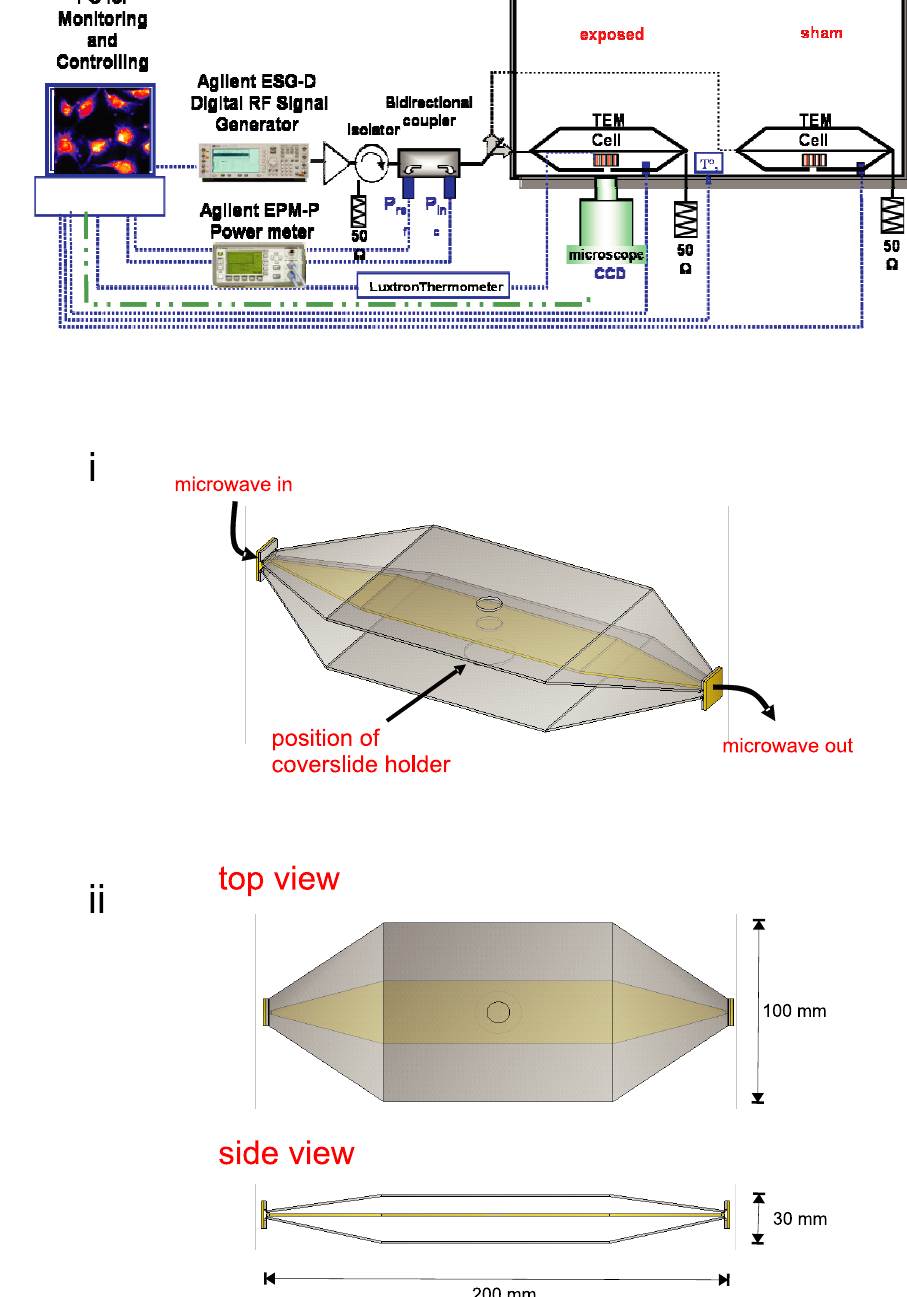
Figure 1. An Imaging-based System for Screening the Cellular Effect of RF Fields. A ; The diagram depicts the screening system configured for the dual TEM cell mode of operation. This configuration permitted two imaging experiments to be carried out simultaneously, with the microscope collecting fluorescence images by alternating between each of the two independent TEM cells. A personal computer controlled the exposure conditions by setting the amplified power output of the Agilent ESG-D RF Signal Generator to one of the two TEM cells, through an in-line bidirectional coupler and an RF switch. An Agilent EPM-P Power meter measured the incident and reflected power at each TEM cell. Each TEM cell was terminated with a 50 Ohm load. The exposure and imaging were carried out in an environmental enclosure, where temperature, CO 2 and humidity were controlled. Bi ; The transverse electromagnetic cell exposure system used TEM cells with open sides. This design permitted the equilibration of temperature, humidity and gases with the environmental enclosure system during the incubation. RF power was delivered to the samples in the TEM cell by SMA connectors and then terminated in a 50 Ohm load. Coverslides were mounted in Teflon chambers and positioned at